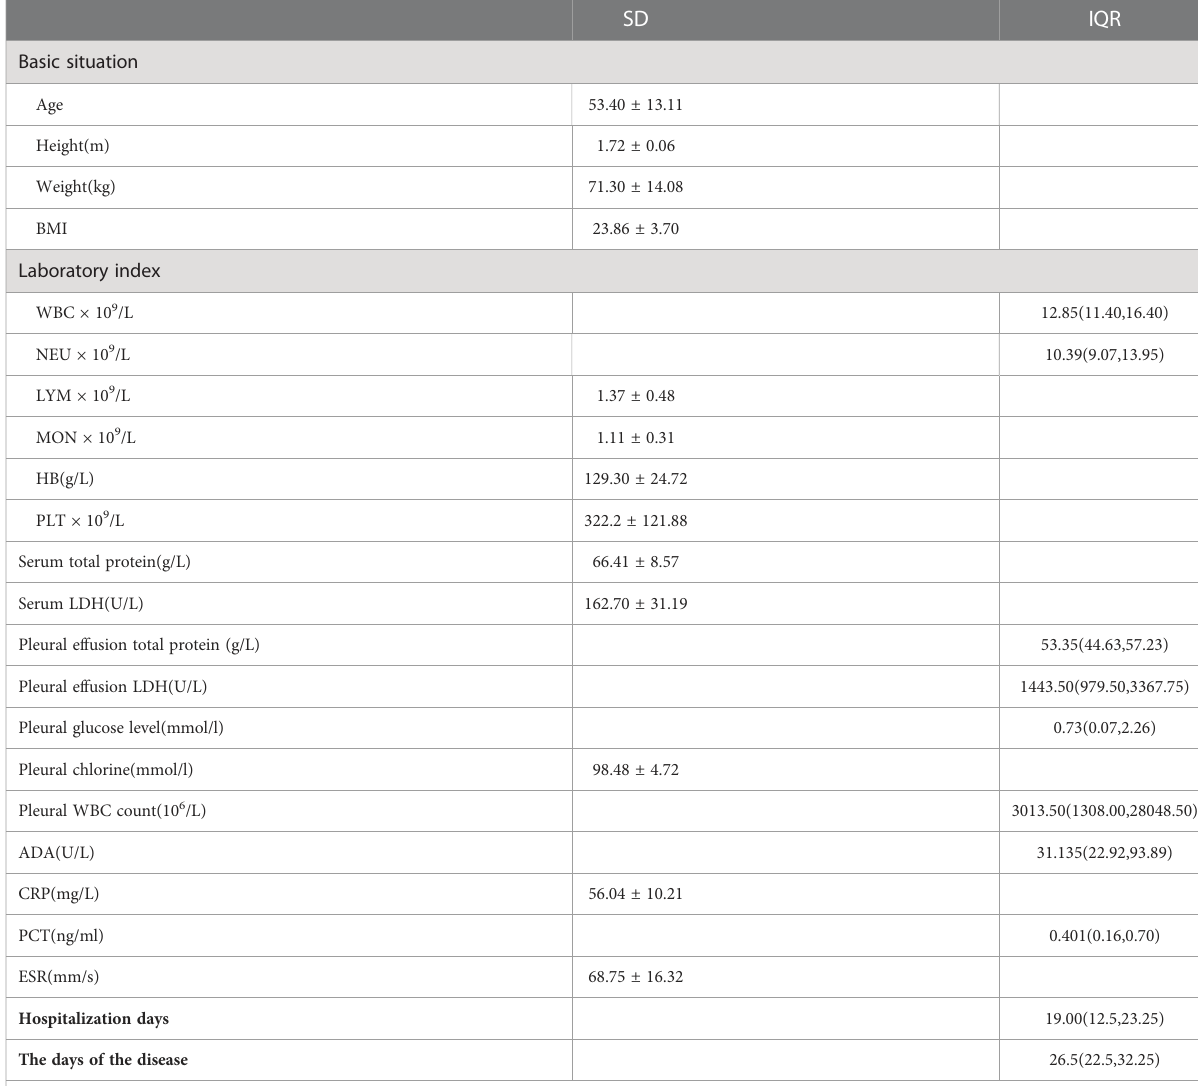
TABLE 2 Patients ’ characteristics and laboratory fi ndings upon